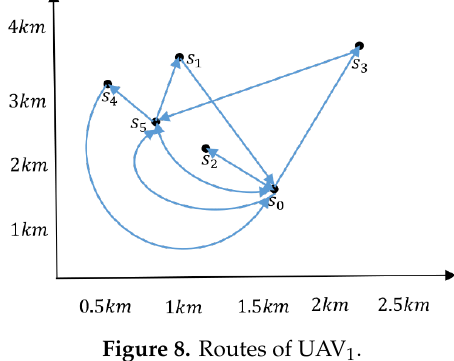
Figure 8. Routes of UAV 1 .